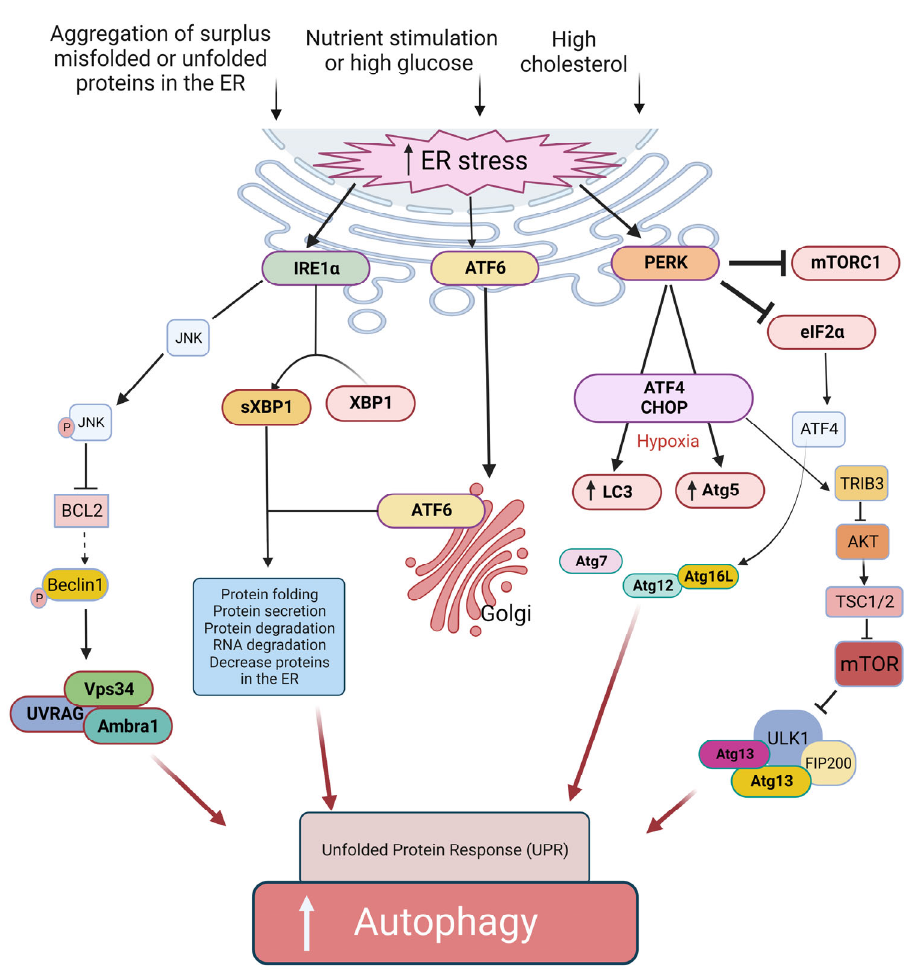
Figure 4. Proposed ER-related mechanisms in the induction of autophagy and UPR in β cells. The ER stress can induce autophagy through PERK, IRE1 α , and the ATF6 α signaling pathway. The ER stress pathway is caused by hyperglycemia and upon accumulation of misfolded and unfolded proteins in the ER lumen. Activation of IRE1 α results in the generation of active sXBP1. The ATF6 α is